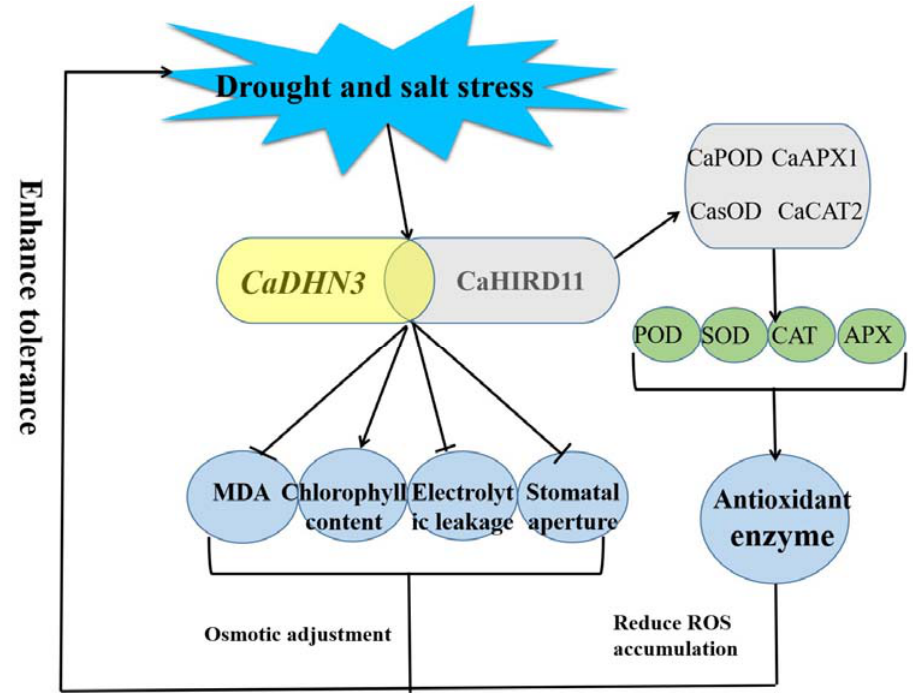
Figure 10. Schematic illustration of the mechanism of salt and drought tolerance regulated by CaDHN3 in pepper. Supplementary Materials: The following are available online at www.mdpi.com/xxx/s1, Figure S1: The phenotypes and analysis of CaDHN3 expression of silencing pepper plants, Table S1: Primers were used for the qRT-PCR.